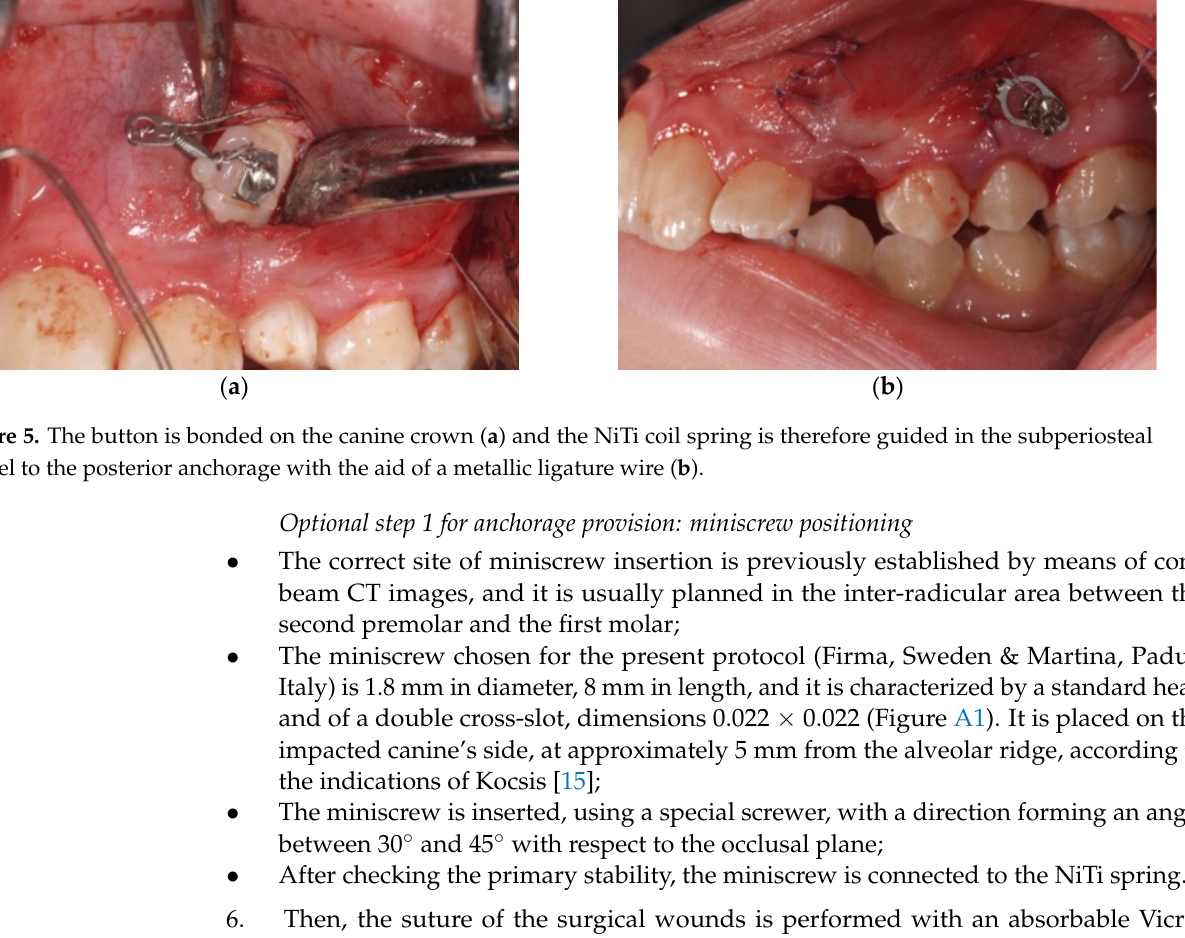
through a sub-periosteal tunnel ( b ).